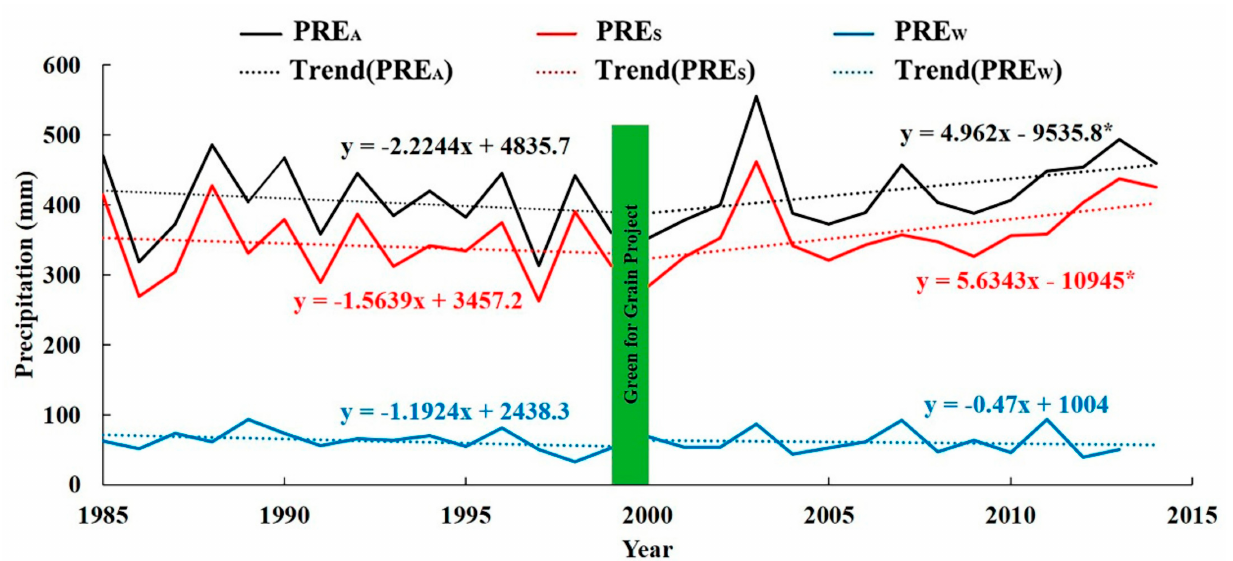
Figure 3. The annual and seasonal changes of precipitation (“ * ” indicates that the trend is statistically significant at the 95% confidence